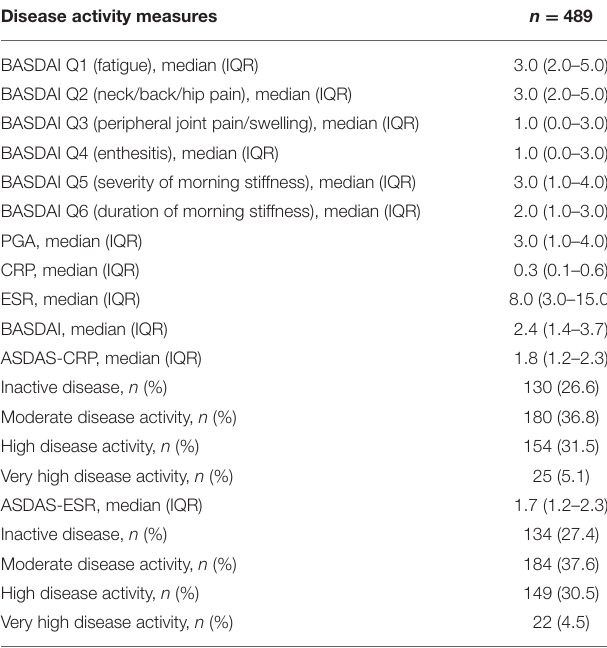
TABLE 2 | Baseline disease activity measures of the study population. Disease activity